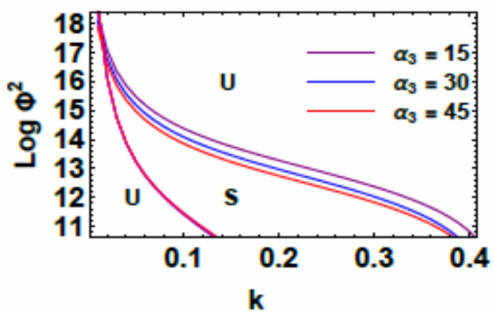
Figure 18. Variation of Log Φ 2 with k to depict the contribution of Equations (53) and (54) along with data A for different values the parameter α 3 .